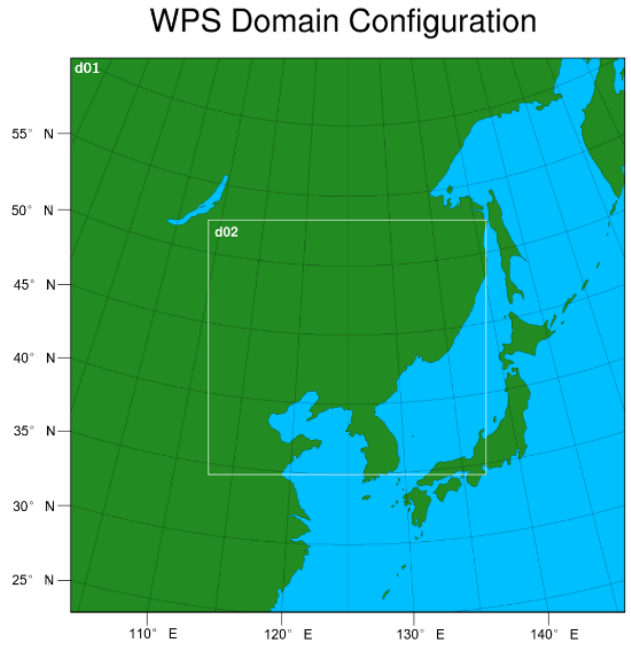
Figure 5. Two nested model domains (D01 and D02) and their horizontal resolutions (9 km and 3 km, respectively).